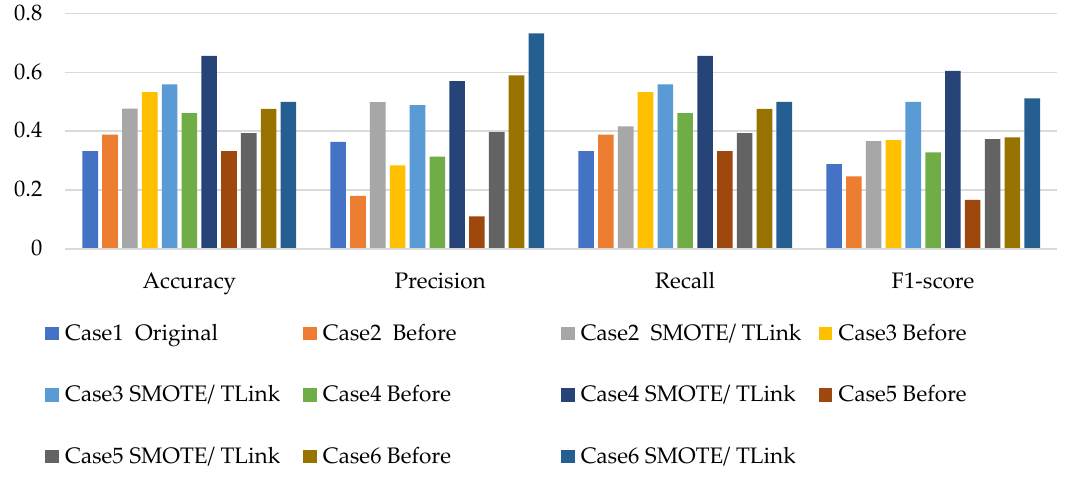
Figure 19. Experimental performance of SVM classification with SMOTE/T-link.